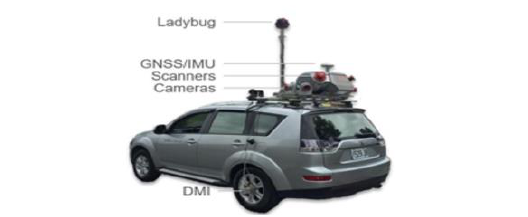
Table 2. Specification of sensors.